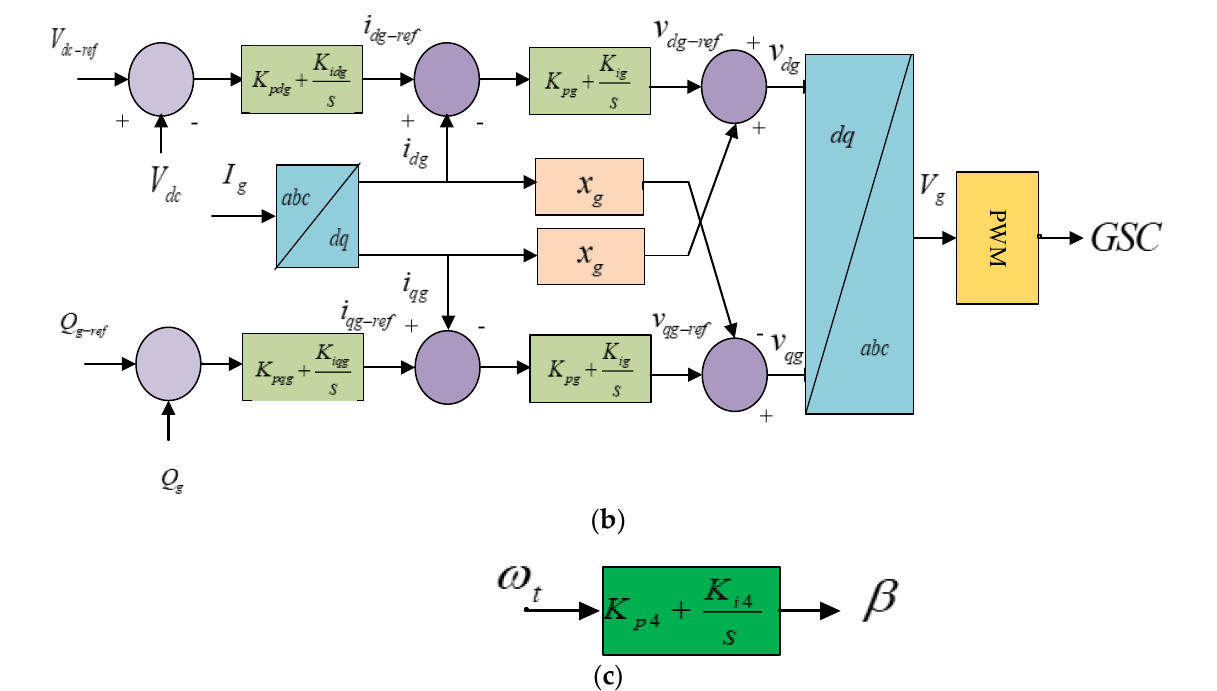
Figure 4. Schematic control diagram of (a) RSC, ( b ) GSC and ( c ) pitch controller. The base rotating speed of a wind turbine is denoted by In Figure 4, the GSC independently controls Q g injected from the power grid and adjust the V DC at a nominal rating. v dg and v qg are used for independent control of V DC and maximum active power. Error signals can be generated by comparing d-q current signals Q g . V DC − ref is the dc link voltage reference, and Q g − ref refers to the reactive power control i to reference signals . The PI controller transmits these i and qr dr error signals from the voltage reference